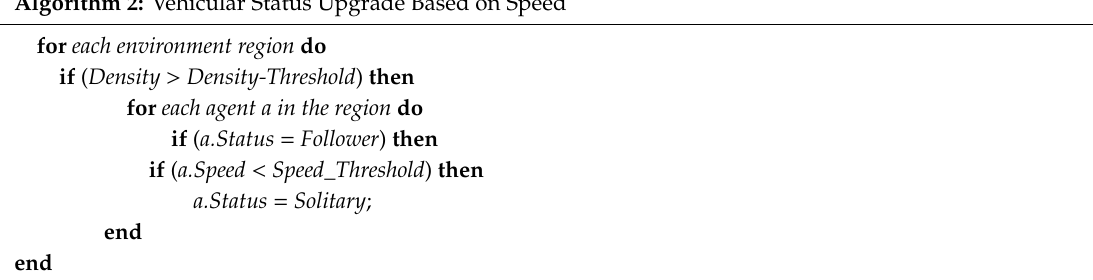
Algorithm 2: Vehicular Status Upgrade Based on